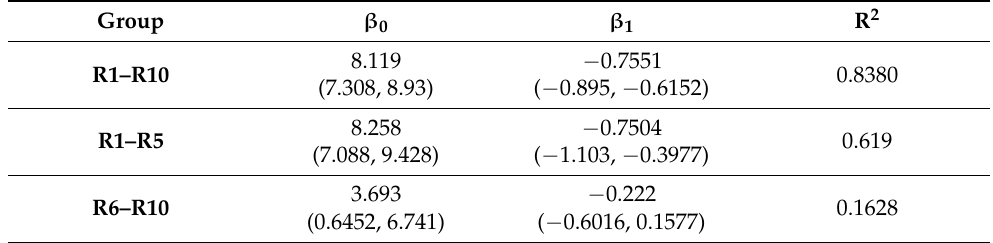
Table 7. Summary of results obtained from the linear fitting (Y = β 0 + β 1 · X) of the fracture toughness, K Q or K Ic . The coefficients β 0 and β 1 · are accompanied with their 95% confidence bounds.